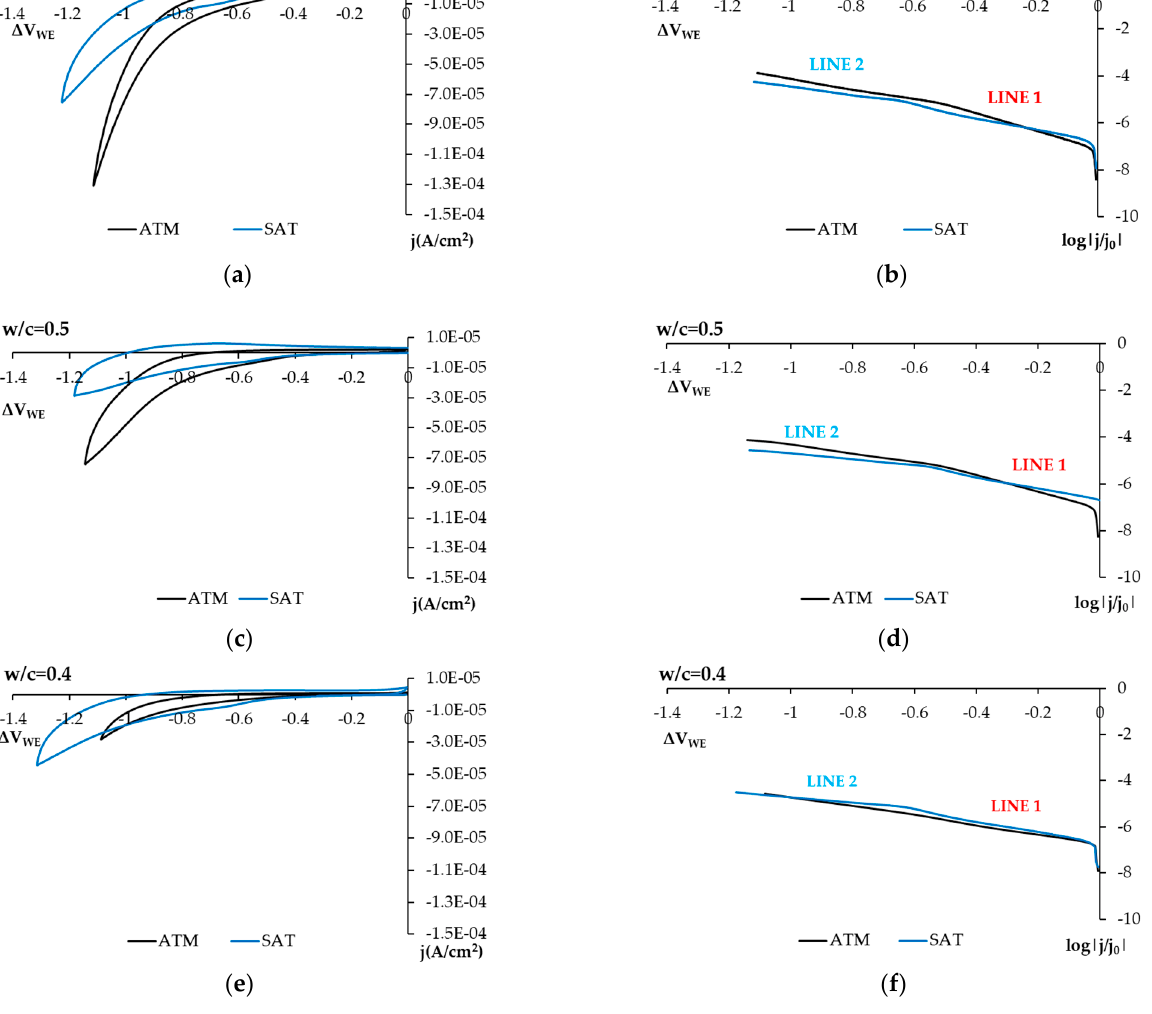
Figure 10. The cyclic voltammetry results obtained with the SS sensor in hardened concrete under atmospheric (ATM) and H 2 O-saturation (SAT) conditions using the 2-electrode technique. Ohm drop is corrected. ( a ) Voltagram of concrete w/c = 0.6. ( b ) Voltagram of cathodic sweeping represented logarithmically and corresponding to Figure ( a ), concrete w/c = 0.6. ( c ) Voltagram of concrete w/c = 0.5. ( d ) Voltagram of cathodic sweeping represented logarithmically and corresponding to Figure ( c ), concrete w/c = 0.5. ( e ) Voltagram of concrete w/c = 0.4. ( f ) Voltagram of cathodic sweeping represented logarithmically and corresponding to Figure ( e ), concrete w/c = 0.4.